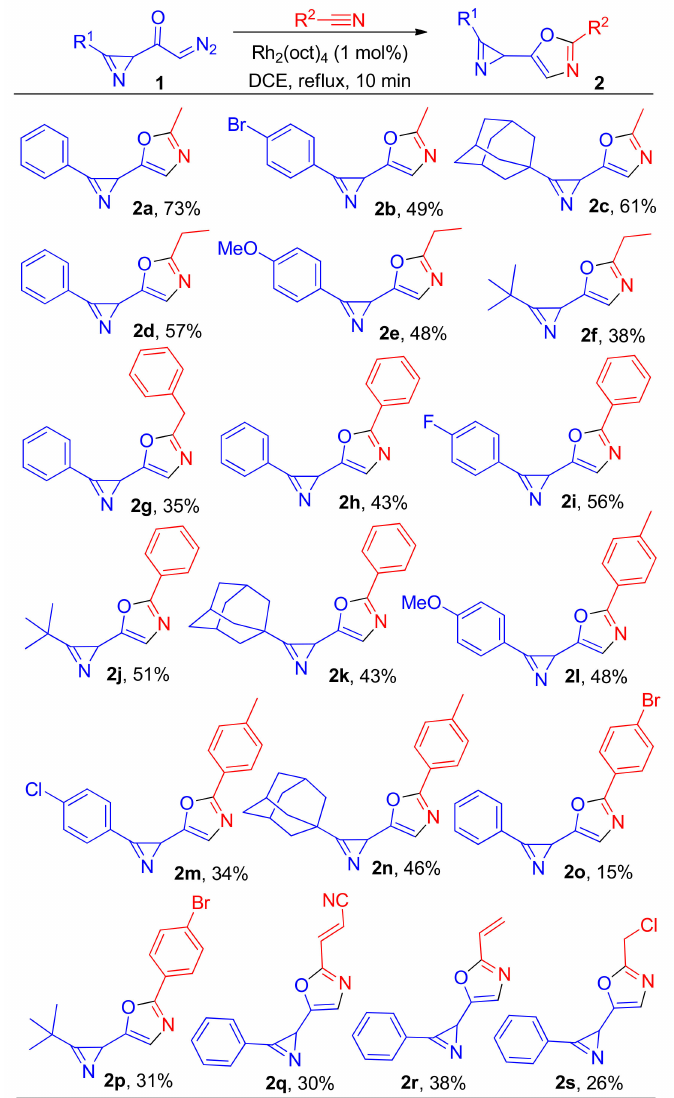
Figure 1. Synthesis of 5-(2 H -azirin-2-yl)oxazoles 2 . Intramolecular ring-to-ring isomerization of azirines with the formation of five- membered nitrogen heterocyles most often occurs under conditions of metal catalysis or thermolysis at high temperatures [2–26]. Using azirine 2a as a test compound, various isomerization conditions (catalysts, solvents, temperatures) were tested to achieve max- imum yield of 4 H -pyrrolo[2,3- d ]oxazole 3a . First of all, iron-containing catalysts, which successfully have been used for isomerization of different azirines, were tested. How- ever, the use of FeCl 2 · 4H 2 O (20 mol%) at various temperatures in acetonitrile (85 ◦ C), 1,4-dioxane (110 ◦ C), mesitylene (170 ◦ C), DMSO (170 ◦ C), anhydrous FeCl 2 (20 mol%) in acetonitrile (85 ◦ C), 1,4-dioxane (110 ◦ C), mesitylene (150 ◦ C), DMSO (150 ◦ C) and anhydrous FeCl 3 (20 mol%) in acetonitrile (85 ◦ C), 1,4-dioxane (110 ◦ C), toluene (110 ◦ C), THF (66 ◦ C) resulted in complete resinification of the reaction mixtures. Similar results were obtained when Co(acac) 2 · (20 mol%), Co(acac) 3 · (20 mol%) were tried as catalysts. The use of ZnBr 2 (20 mol%), CuOAc (20 mol%), [(MeCN) 4 Cu]BF 4 (20 mol%), Cu(tfacac) 2 (20 mol%), Yb(Tf) 3 (20 mol%) in acetonitrile (85 ◦ C), 1,4-dioxane (110 ◦ C), toluene (110 ◦ C), DMF (110 ◦ C) also resulted in complete resinification of the reaction mixtures. Heating of azirine 2a in the presence of NiCl 2 · 6H 2 O (20 mol%) in acetonitrile (85 ◦ C), 1,4-dioxane (110 ◦ C), toluene (110 ◦ C) gave only traces of pyrrolooxazole 3a . It was suggested that